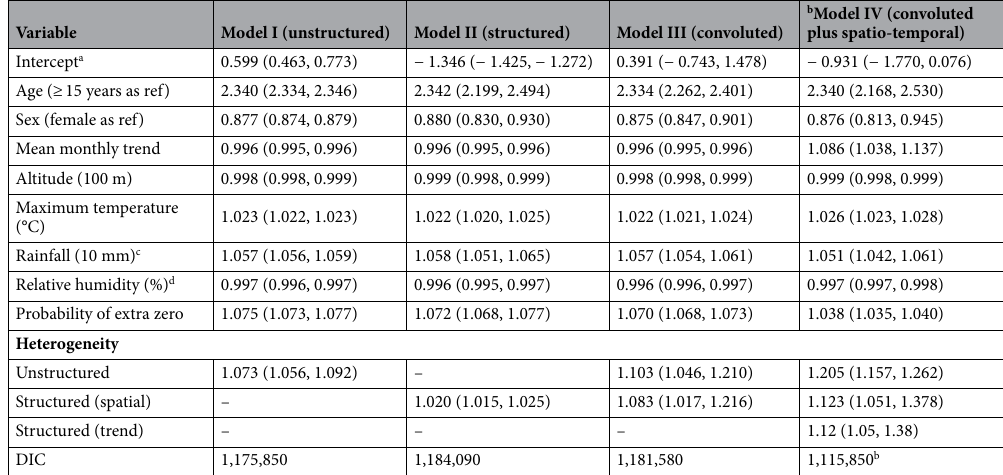
Table 3. Relative risk and 95% credible interval from Bayesian spatial and non-spatial models of common colds in Bhutan, January 2010–December 2018. DIC deviation information criterion, mm millimetre. a Coefficient; b best-fit model; c lagged 1 month; d lagged 3